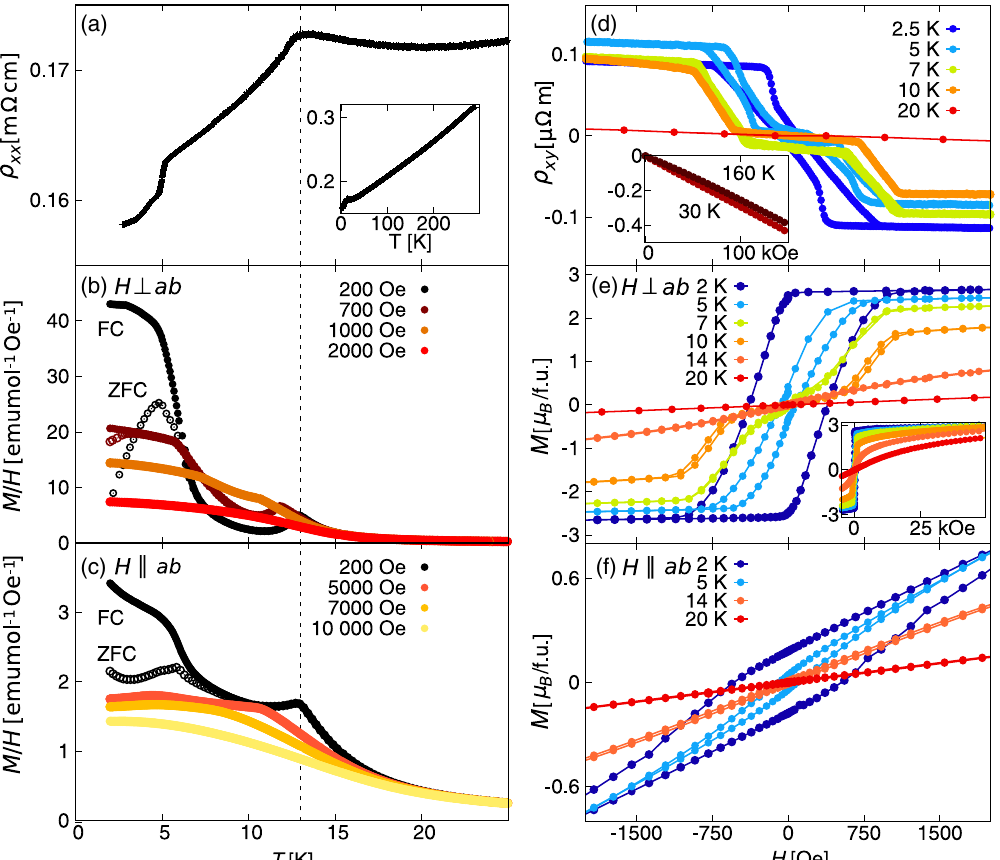
FIG. 2. Magnetic and transport properties of Mn147. (a) In-plane electrical resistivity as a function of the temperature. (b),(c) Normalized magnetization as a function of temperature for fields applied both perpendicular and parallel to the ab directions. Open and filled symbols correspond to ZFC and FC protocols, respectively. (d),(e) Hall resistivity and magnetization as a function of the field applied perpendicular to the ab planes. (f) Magnetization as a function of the field applied parallel to the ab planes. The hysteretic behavior for temperatures T ≤ 5 K indicates ferromagnetic (intraplane)